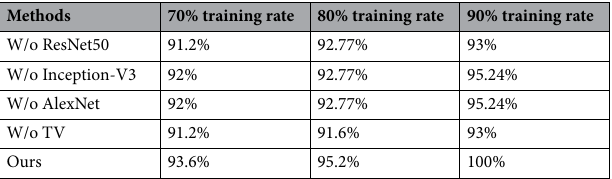
Table 9. Ablation study of key components (CNNs and TV) in our